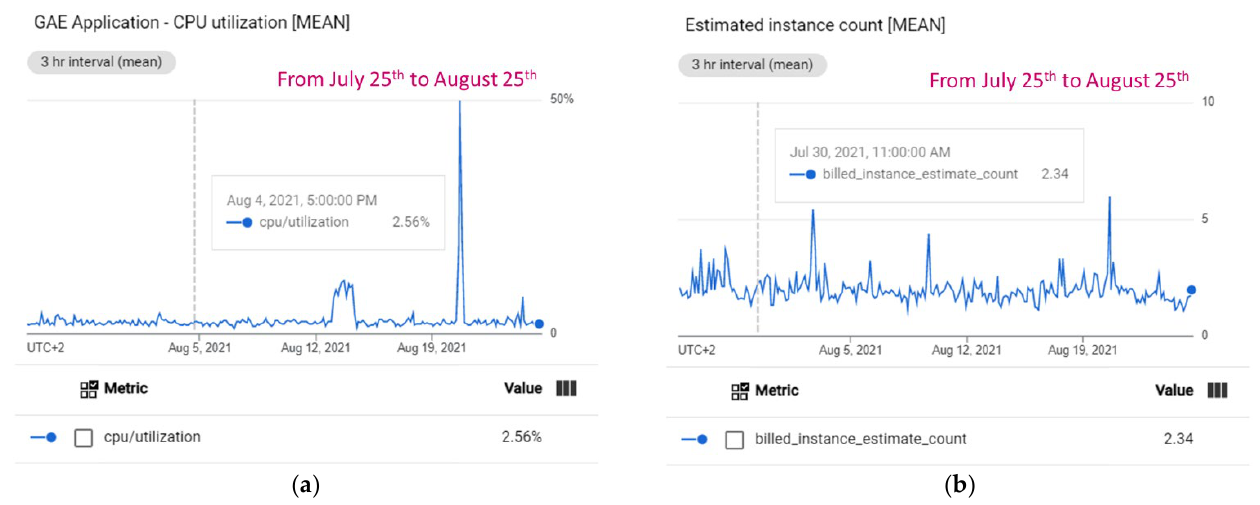
Figure 11. Performance measurements in a month. ( a ) CPU utilization during the analyzed period. ( b ) Estimated instance count during the evaluated period.